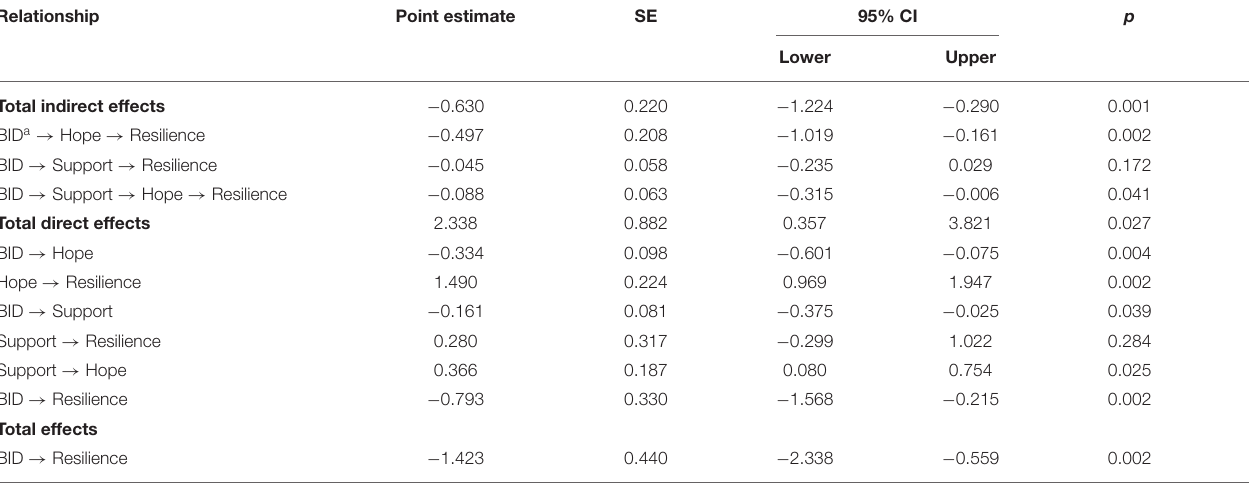
TABLE 3 | Direct and indirect effects of hope and social support on association between body image distress and resilience.